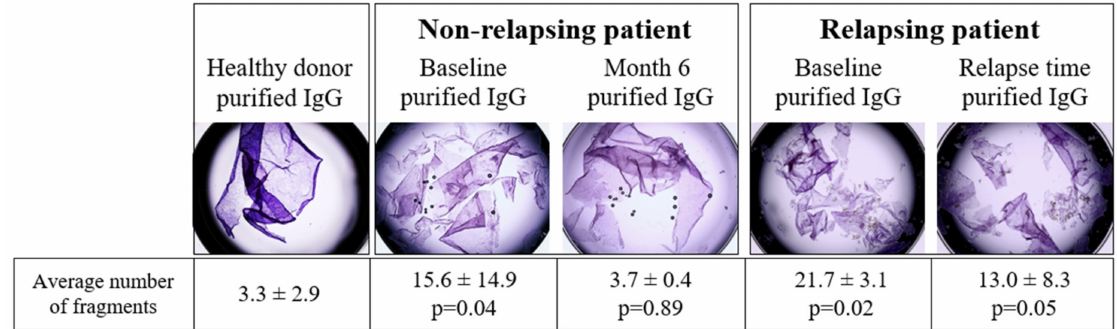
Figure 5. Pathogenicity evaluation of purified IgG from relapsing and non-relapsing patients at baseline and relapse time or M6, respectively. Keratinocyte dissociation assay was used to assess the pathogenicity of purified IgG from healthy donors (negative control) ( n = 6), relapsing patients (at baseline and relapse time) ( n = 3) and non-relapsing patients (at baseline and Month 6) ( n = 3). In brief, HaCaT cells pre-incubated for 24 h with purified IgG were dissociated from the plate with dispase, and the monolayers were mechanically disrupted. The number of cell fragments was proportional to the IgG pathogenicity. The p -value was calculated in comparison to the healthy donor. A representative image of three independent experiments performed with serum from three patients is